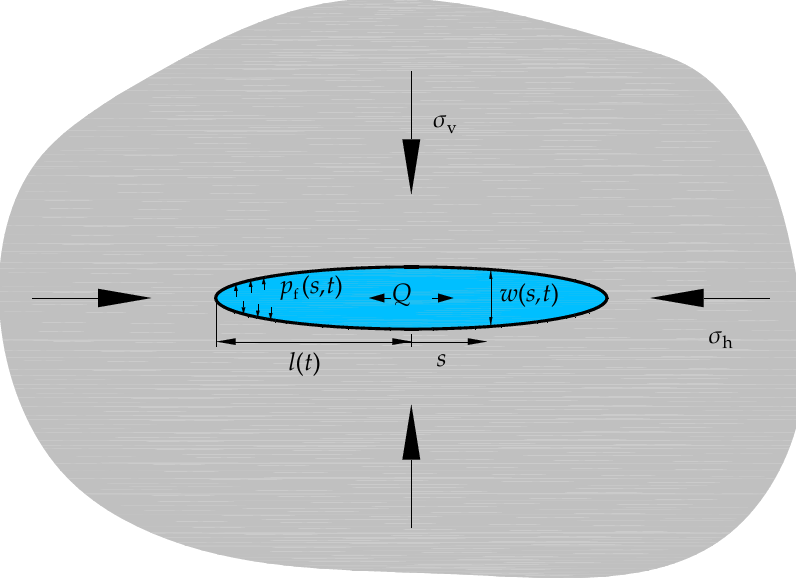
Figure 1. Schematic of single hydraulic fracture propagation.